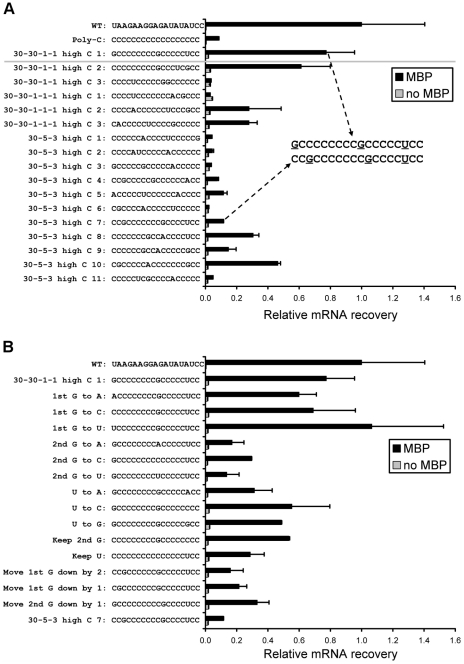
Single-clone ribosome display.(A) The poly-C consensus sequence displayed very low activity relative to the WT pRDV sequence, but one of the most C-rich clones had an efficiency of ∼80% compared to WT (cf. the three sequences above the horizontal gray line). Nearly all highly C-rich clones exhibited activity. Interestingly, the most efficient clones (30-30-1-1 high C 1 and 30-30-1-1 high C 2) both contained G at position -9 and a non-C nucleotide at position −3. Clone 30-5-3 high C 7 was highly similar to 30-30-1-1 high C 1, although the latter was far more efficient. (B) A panel of mutants was created to study the differential activity of two similar clones in (A). Mutational analysis revealed the importance of positions −9 and −3. Error bars indicate half range of duplicates. MBP = maltose-binding protein.